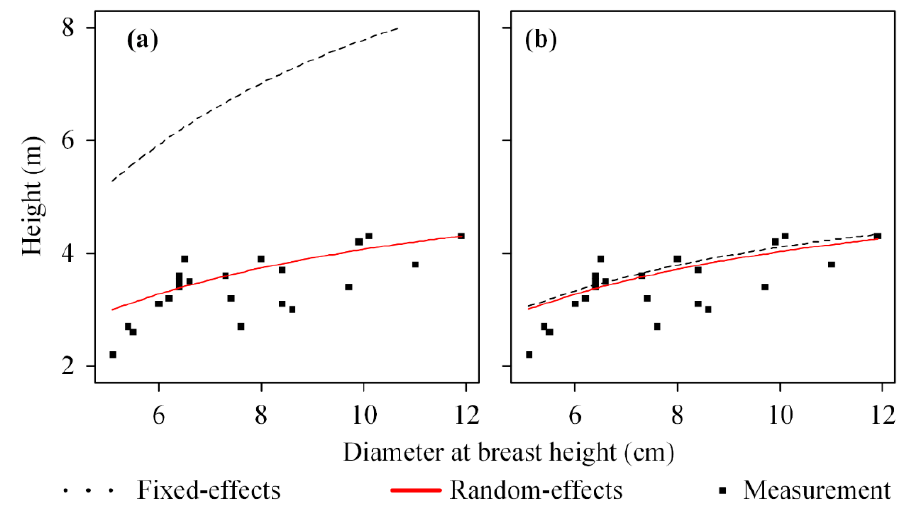
Figure 7. Fixed- and random-effects prediction performance for the basic ( a ) and generalized ( b ) mixed-effects models in an example plot. ( a ) The curve of random-effects prediction of basic mixed-effects model was based on calibration with the two thickest trees. ( b ) The curve of random-effects prediction was based on calibration with one medium-sized tree.